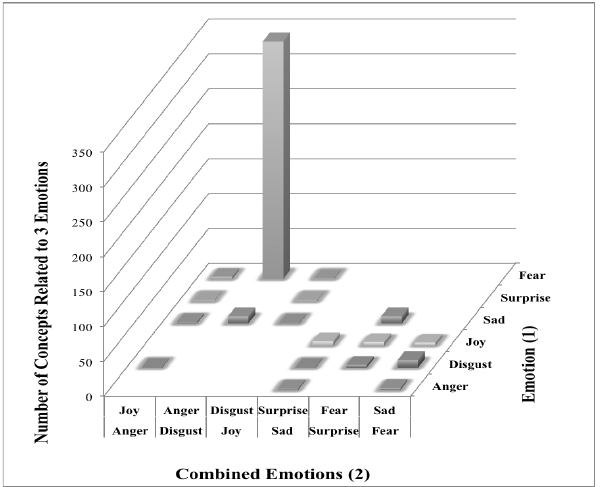
Figure 4. Combination of 3 emotions per concept